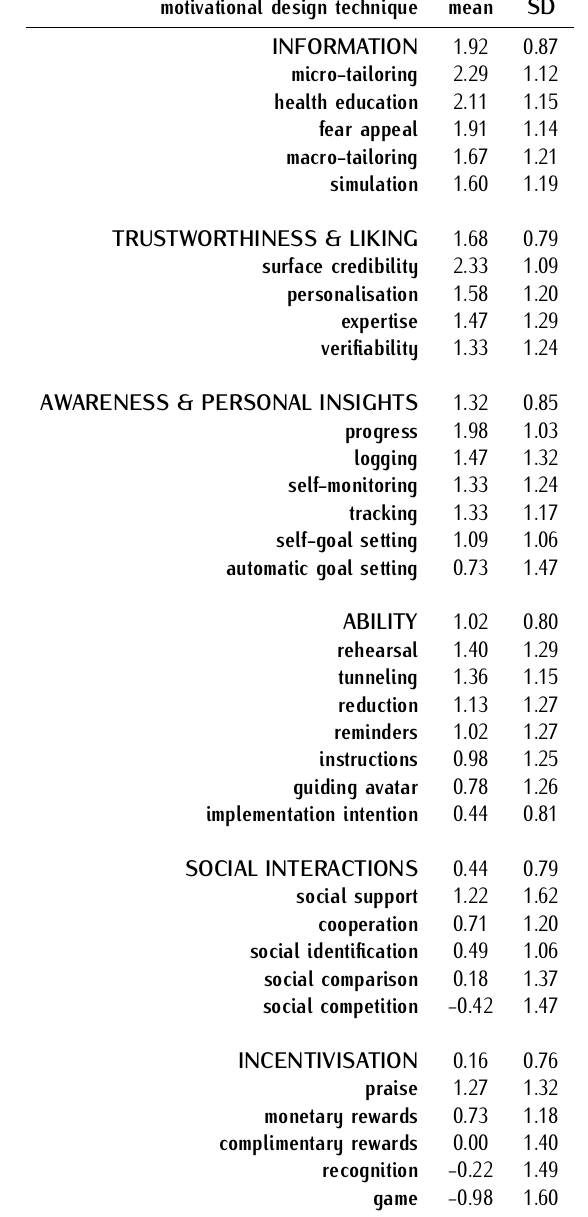
Table 4. Preference scores of motivational design techniques. motivational design technique